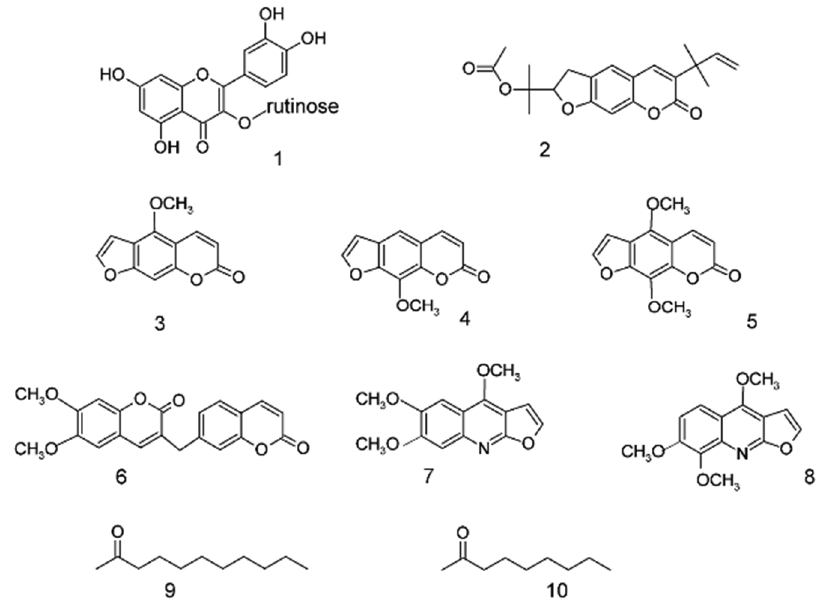
Figure 1. Isolated phytochemicals from rue. 1 : rutin; 2 : rutamarin; 3 : bergapten; 4 : xanthotoxin; 5 : isopimpinellin; 6 : O -methyl-daphnoretin; 7 : kokusaginin; 8 : skimmianine; 9 : 2-undecanone; 10 :